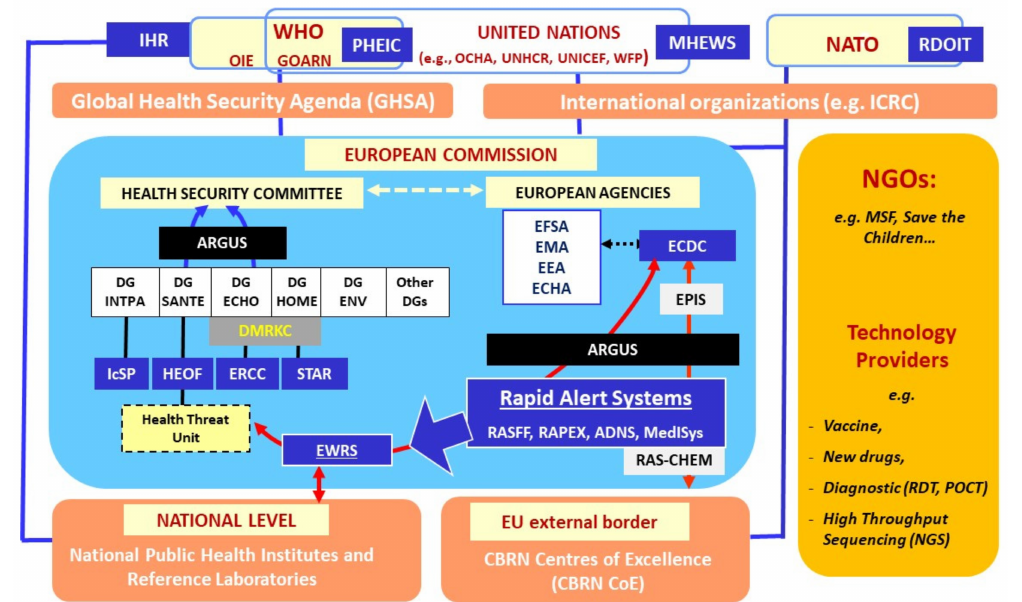
Figure 1. Overview of the health crisis stakeholders’ interactions and alert mechanisms at the international, European, and national levels. ADNS: Animal Disease Notification System; ARGUS: Alerte Rapide, Globale et Sûre, the internal general European rapid alert system, which is an internal crisis management mechanism of the Commission; DG: Directorate- General–Internal Partnerships (INTPA); Health and Food Safety (SANTE), Environment (ENV), Humanitarian Aid and Civil Protection (ECHO), Migration and Home Affairs (HOME); CBRN CoE: Chemical Biological Radiological and Nuclear Risk Mitigation Centres of Excellence; DMRKC: Disaster Risk Management Knowledge Centre, which supports the translation of complex scientific data and analyses into usable information and provides science-based advice for DRM policies; ECDC: European Centre for Disease Prevention and Control; EEA: European Environment Agency; EFSA: European Food Safety Authority; EMA: European Medicines Agency; EPIS: Epidemic Intelligence Information System, an alert and risk assessment system for threats of a biological origin; ERCC: Emergency Response Coordination Centre; EWRS: Early Warning and Response System, a rapid alert system for notifying alerts at the EU level on serious cross-border threats to health; GOARN: Global Outbreak Alert and Response Network; HEOF: Health Emergency Operation Facility, which coordinates the management of public health emergency at the EU level; ICRC: International Committee of the Red Cross; IsSP: Instrument contributing to Stability and Peace, the largest European civilian external security programme; IHR: International Health Regulations, an international legal instrument that covers measures for preventing the transnational spread of infectious diseases; OCHA: Office for the Coordination of Humanitarian Affairs; OIE: World Organization of Animal Health; MediSys: Medical information system; MSF: M é decins Sans Fronti è res (Doctors without Borders); PHEIC: Public Health Emergency of International Concern, a formal declaration by WHO of “an extraordinary event which is determined to constitute a public health risk to other States through the international spread of disease and to potentially require a coordinated international response”; POCT: point-of-care tests; RAPEX: Rapid Exchange of Information System, and alert system for unsafe consumer products and consumer protection (non-food products); RASCHEM: Rapid Alert System for chemicals; RASFF: Rapid Alert System for Food and Feed; RDT: Rapid Diagnostic Tests; RDOIT: Rapidly Deployable Outbreak Investigation Team, which aims to investigates outbreak(s) or incidents(s) where the intentional use of biological agents (biowarfare, bioterrorism, or biocrime) cannot be excluded; NATO: North Atlantic Treaty Organization; UNHCR: United Nations High Commissioner for Refugees; UNICEF: United Nations Children’s Fund; WHO: World Health Organization; WFP: World Food